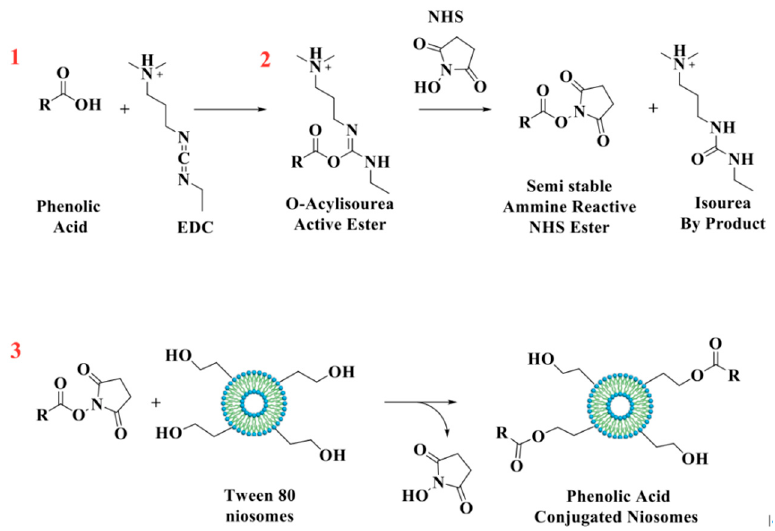
Figure 1. Schematic representation of the reaction between antioxidant molecules and